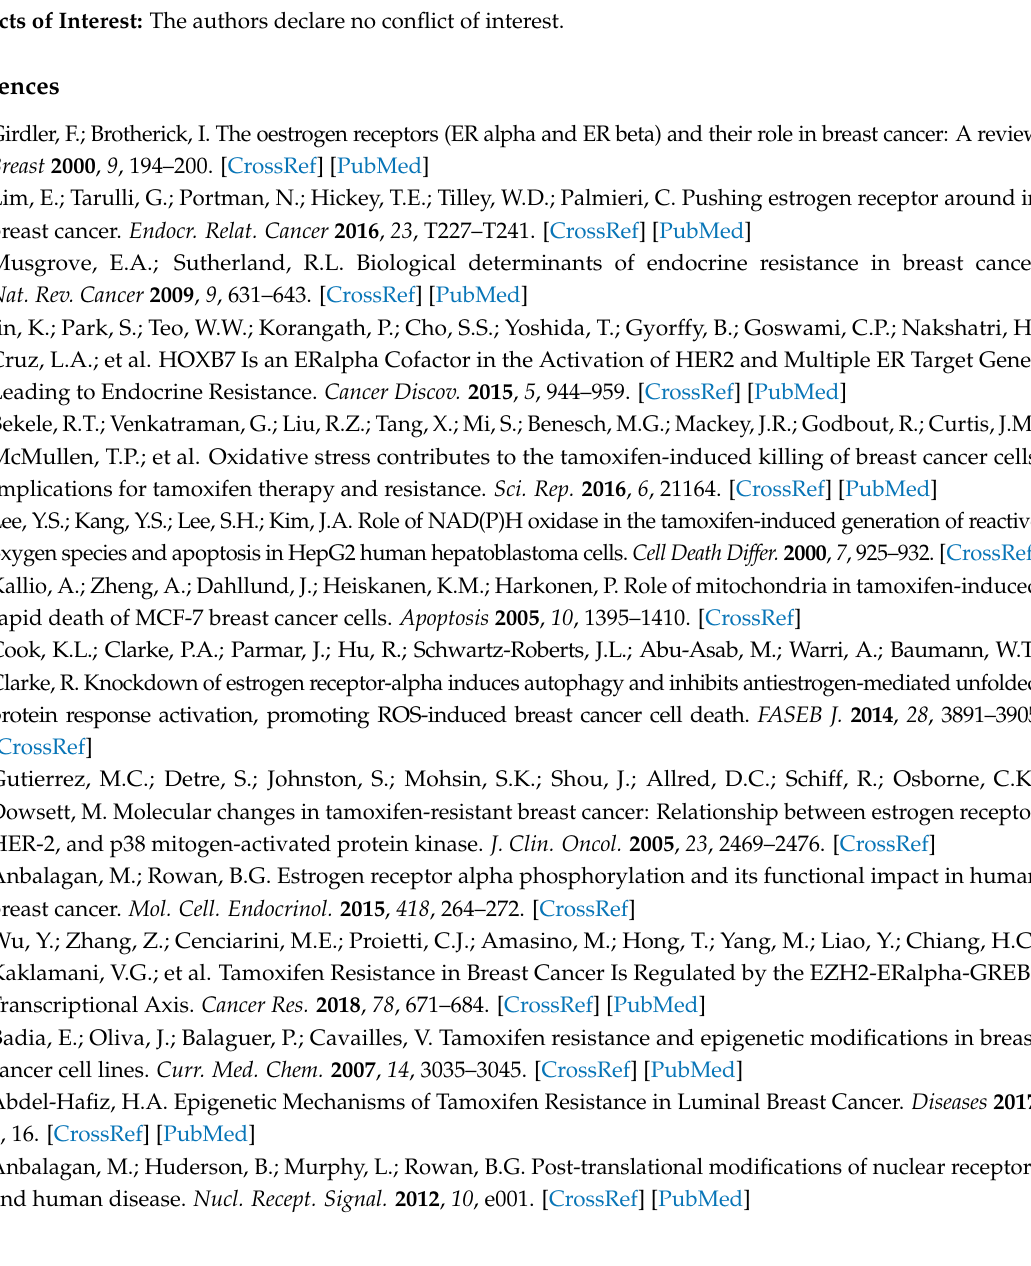
Figure S1: Tamoxifen-talazoparib co-administration decrease cell survival and increase PARP activity, Figure S2: Tamoxifen-talazoparib efficacy is ER α -dependent, Figure S3: Tamoxifen and talazoparib alter ER α nuclear miR-222 inhibition decreases expression of miR-222, Figure S6: Proposed